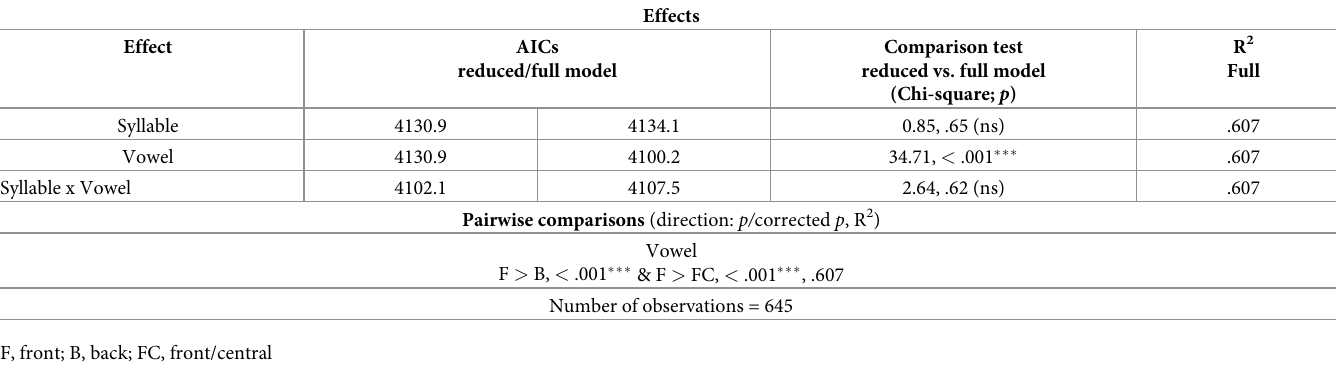
Table 9. Effects on mean slope of F 2 transition (Hz/ms) at the midpoint of the steady